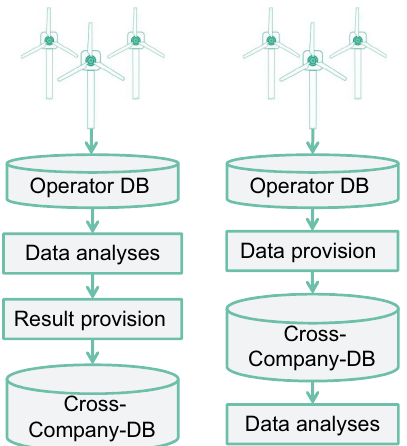
Figure 1. Possible architectures to gather and analyze cross-company performance and reliability